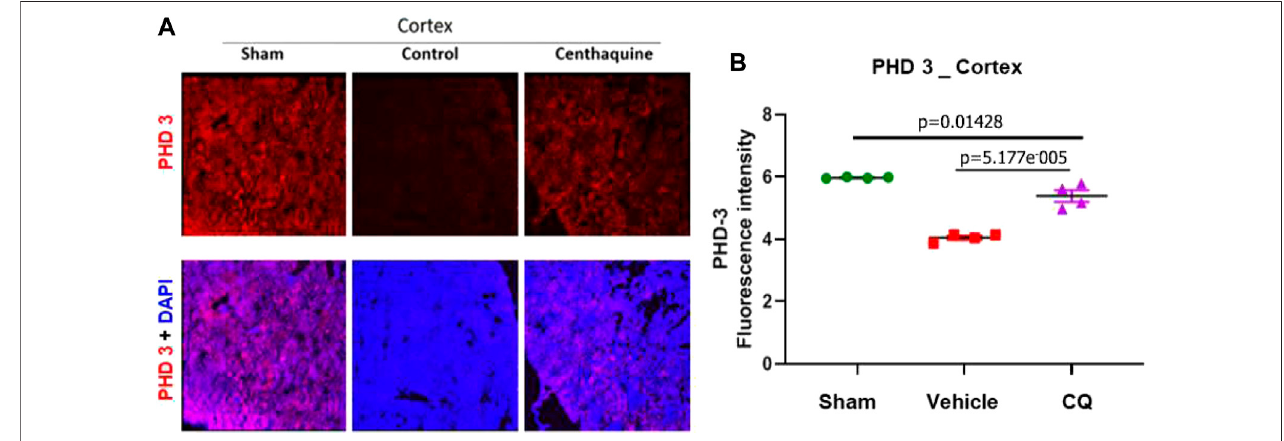
FIGURE 5 | Expression of hypoxia responsive factor, PHD 3 in kidney cortex. (A) , representative images of immuno fl uorescence of PHD 3 (red) in cortex (A) in sham, vehicle(control)andCQ. (B) ,agraphofmean fl uorescence intensityofPHD3incortex. N (cid:1) 4. Nucleiinallimmuno fl uorescencemicroscopyimages werestained with DAPI (blue). Statistical analysis Ordinary One Way ANOVA and Fisher ’ s test.